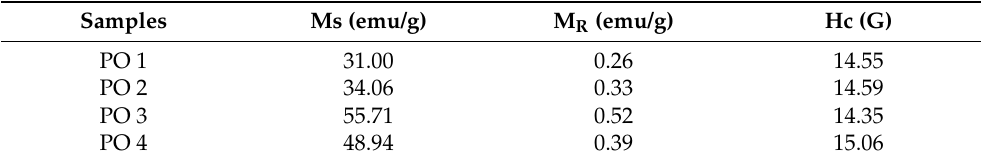
Table 9. Magnetic properties of MREs for different ratios of PO:AO.